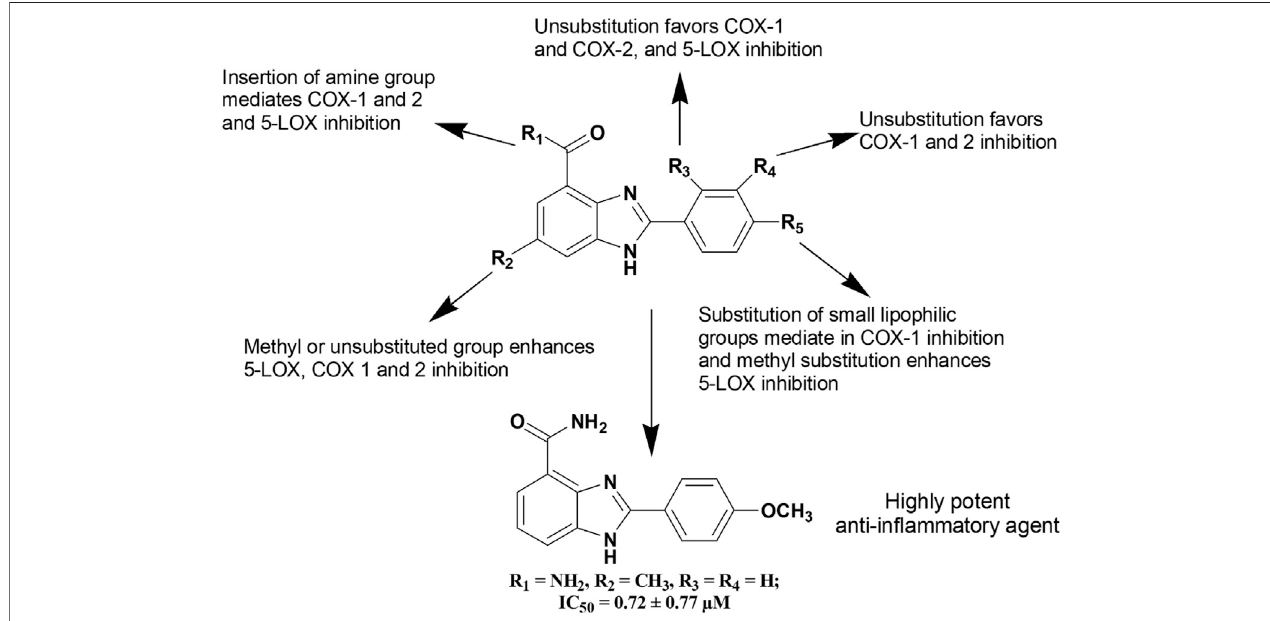
FIGURE6| Structureactivityrelationship(SAR)ofbenzimidazolederivativeshavinganti-in fl ammatoryactivity.The fi gurerepresentstheSARstudiesaccomplished by Bukhari et al. (2016).